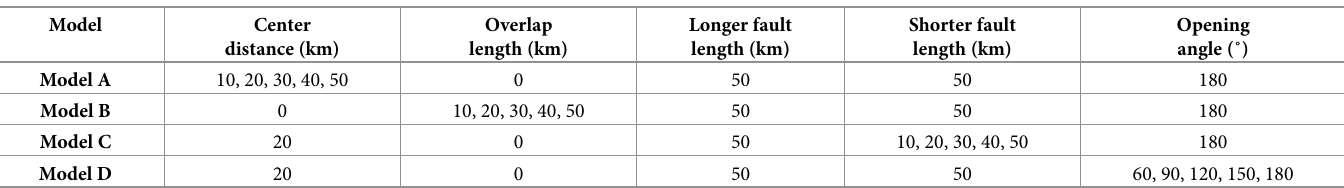
Table 1. Parameters of faults in the conceptual models.